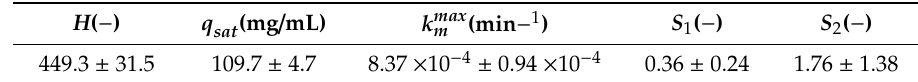
Table 4. Fitting parameter of the lumped kinetic model (LKM) optimized on breakthrough